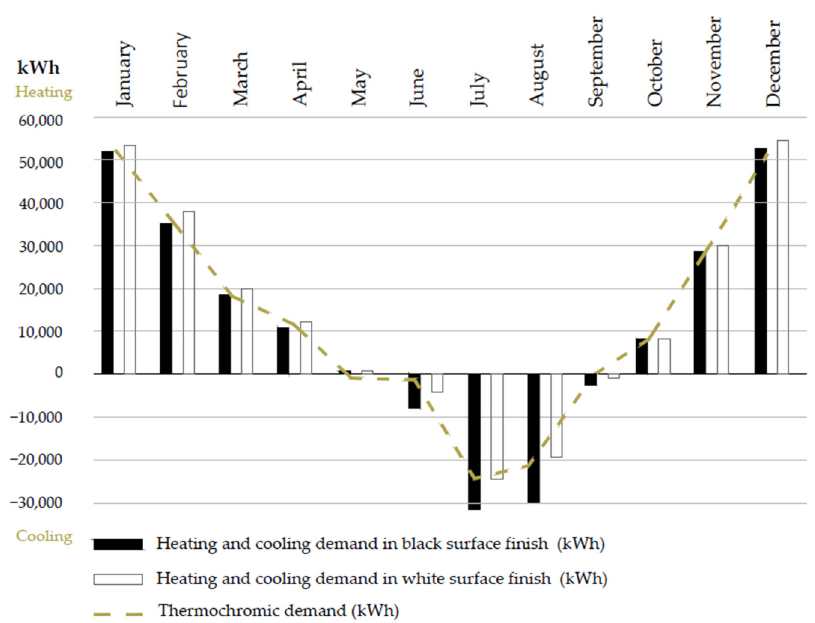
Figure 8. Monthly demand for NBE-79 with black, white, and thermochromic roof surface finishes in the Madrid CZ.